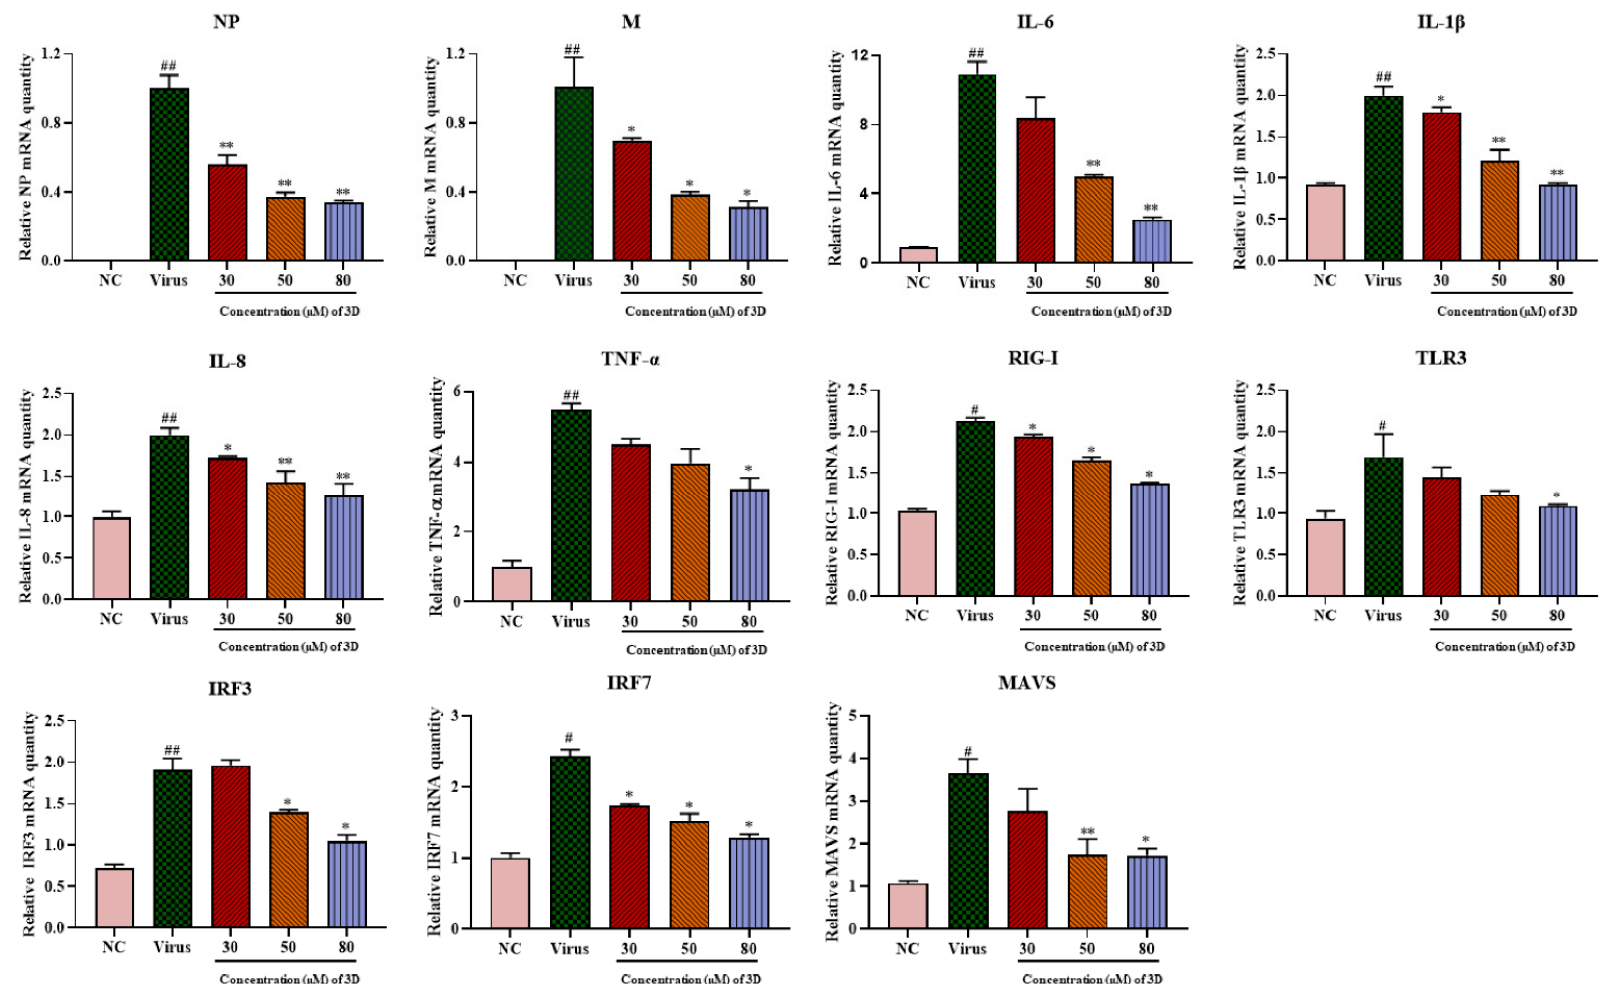
Figure 5. Effects of 3D on the expression of inflammatory mediators in A549 cells. Infected A549 cells were incubated in the absence or presence of the indicated concentrations of 3D (the X -axis) for 24 h. Subsequently, total RNA was extracted, and the qRT-PCR assay was performed to figure out the expression level of mRNA. ( # p < 0.05, ## p < 0.01 as compared with the normal control; * p < 0.05, ** p < 0.01 compared with the virus